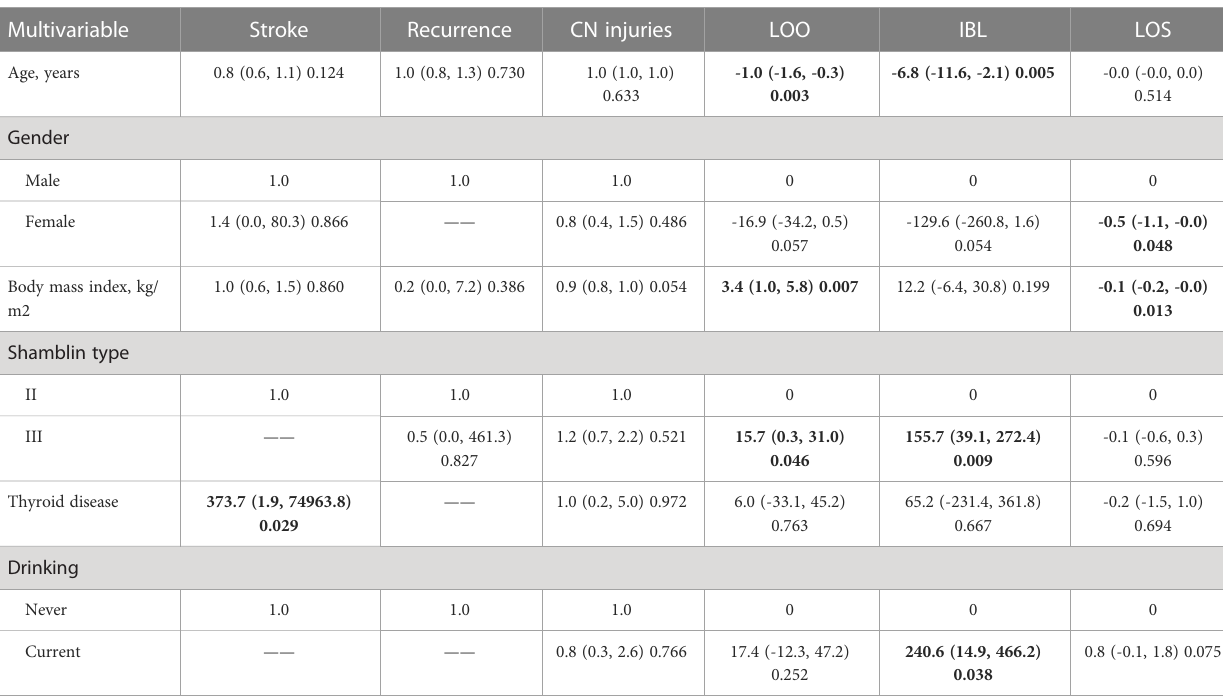
TABLE 3 Multivariable regression analysis for primary and secondary